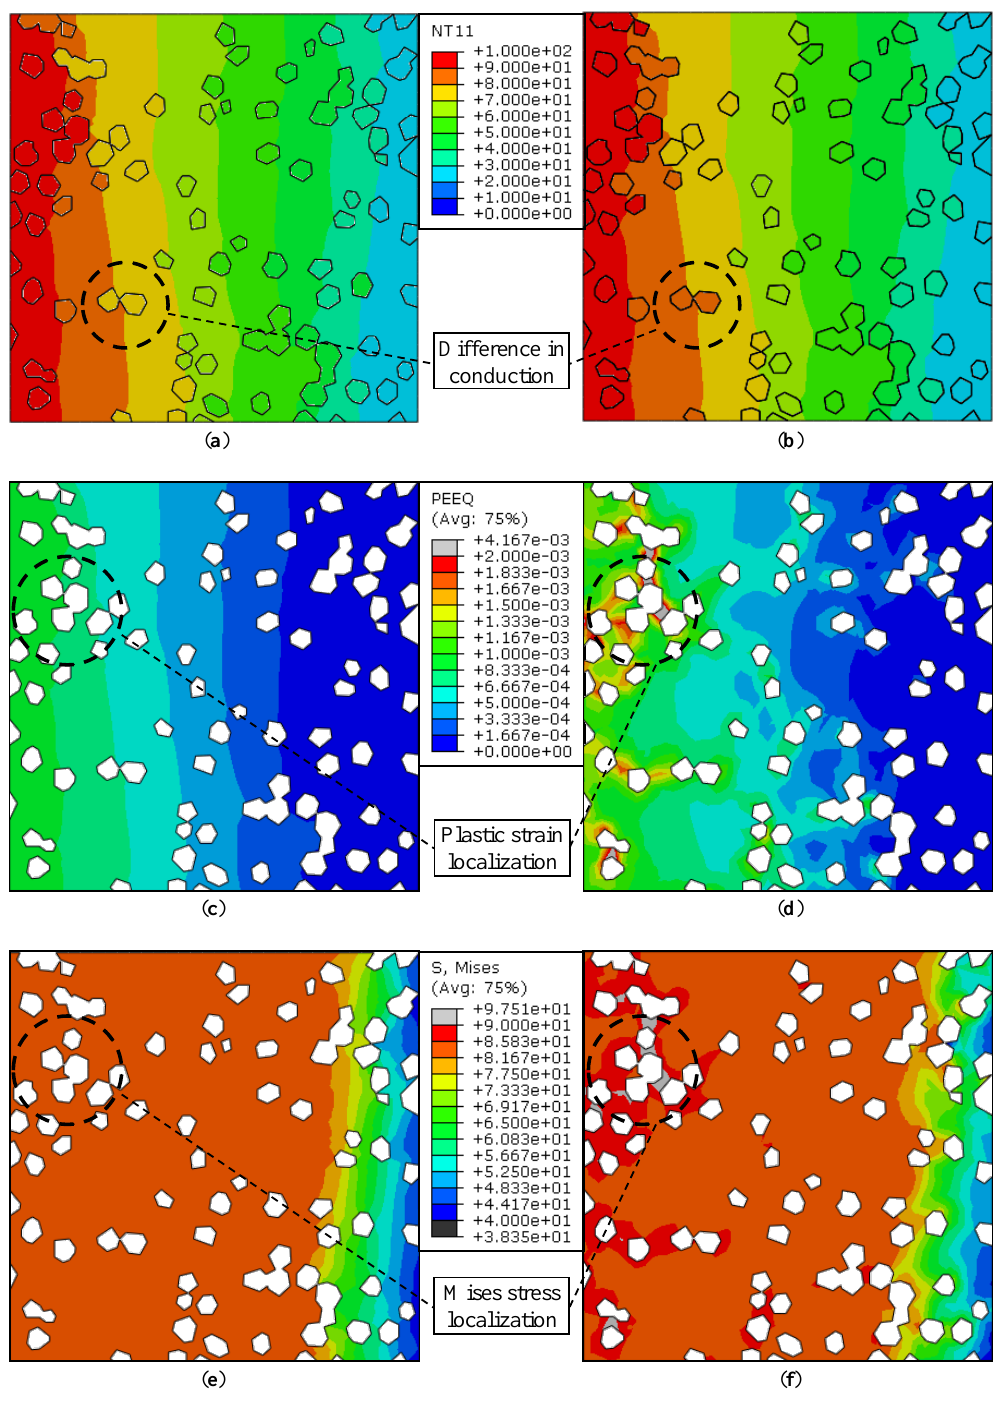
Figure 6. Steady-state analysis with interacting surfaces—Contours of ( a ) Case 2: Nodal temperature (°C); ( b ) Case 3: Nodal temperature (°C); ( c ) Case 2: Equivalent plastic strain; ( d ) Case 3: Equivalent plastic strain; ( e ) Case 2: Mises equivalent stress (MPa); and ( f ) Case 3: Mises equivalent stress (MPa).